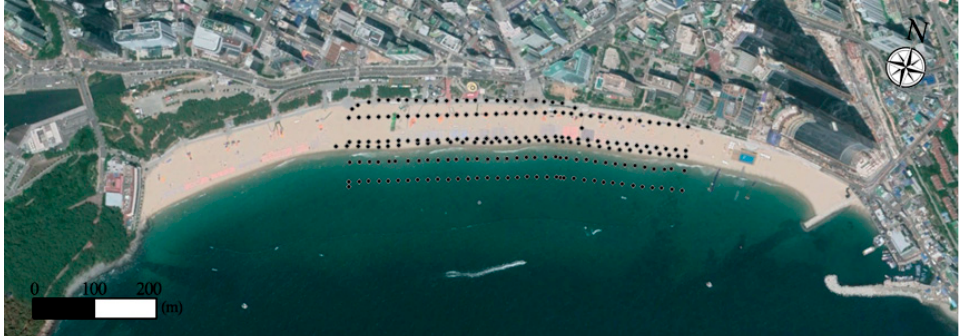
Figure 4. The Ground Control Point (GCP)-surveyed points along Haeundae Beach.